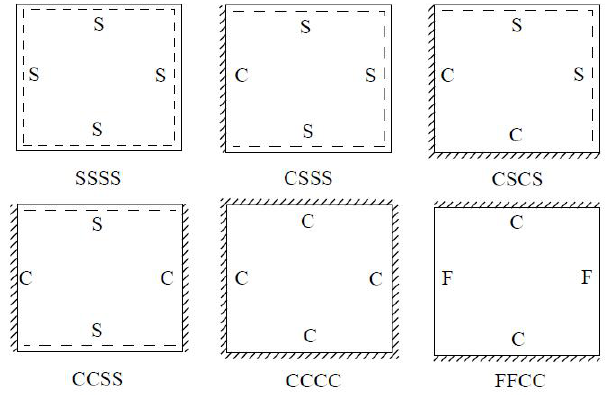
Figure 6. Typical boundary conditions of the OSFP.